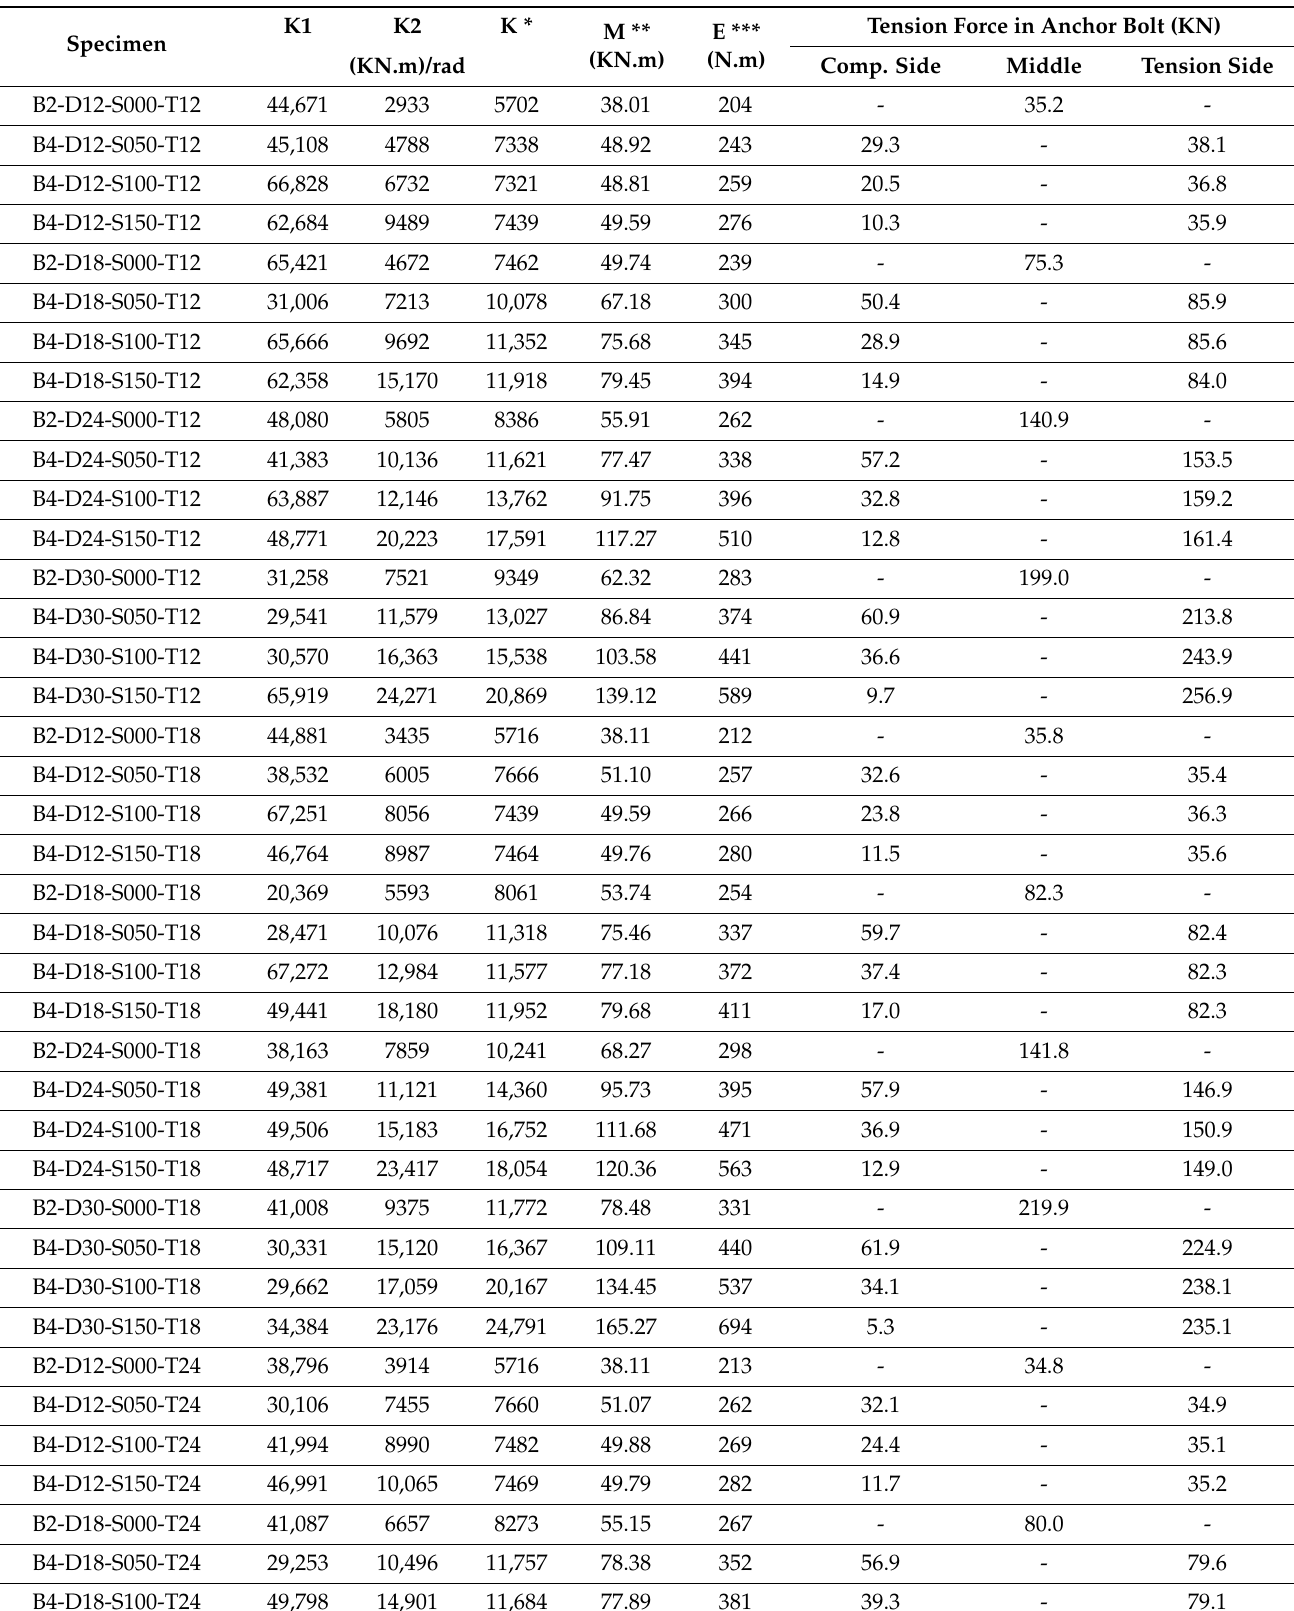
Table 3. Rotational stiffness, energy absorption, piecewise linear idealization, and moment capacity for the analyzed specimens.